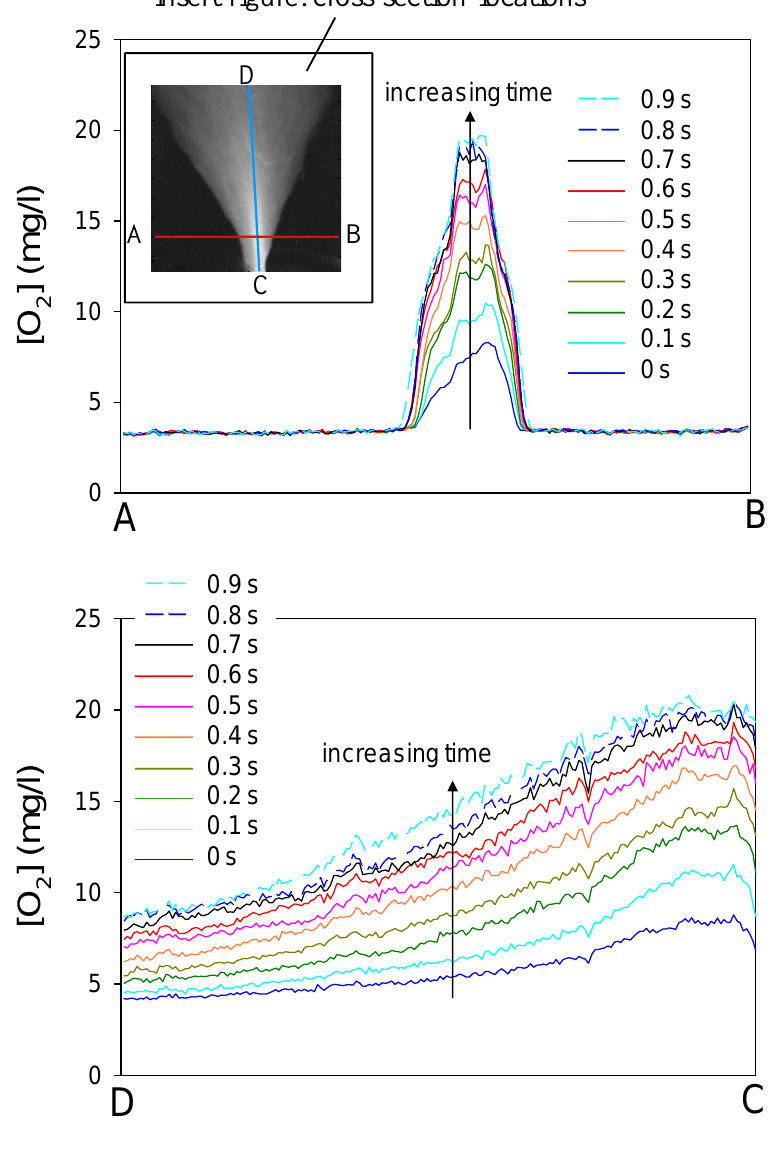
figure: cross-section